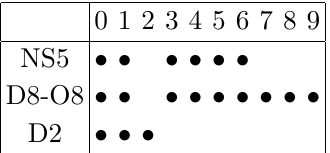
Table 1 . Brane con(cid:12)guration for the E-strings.